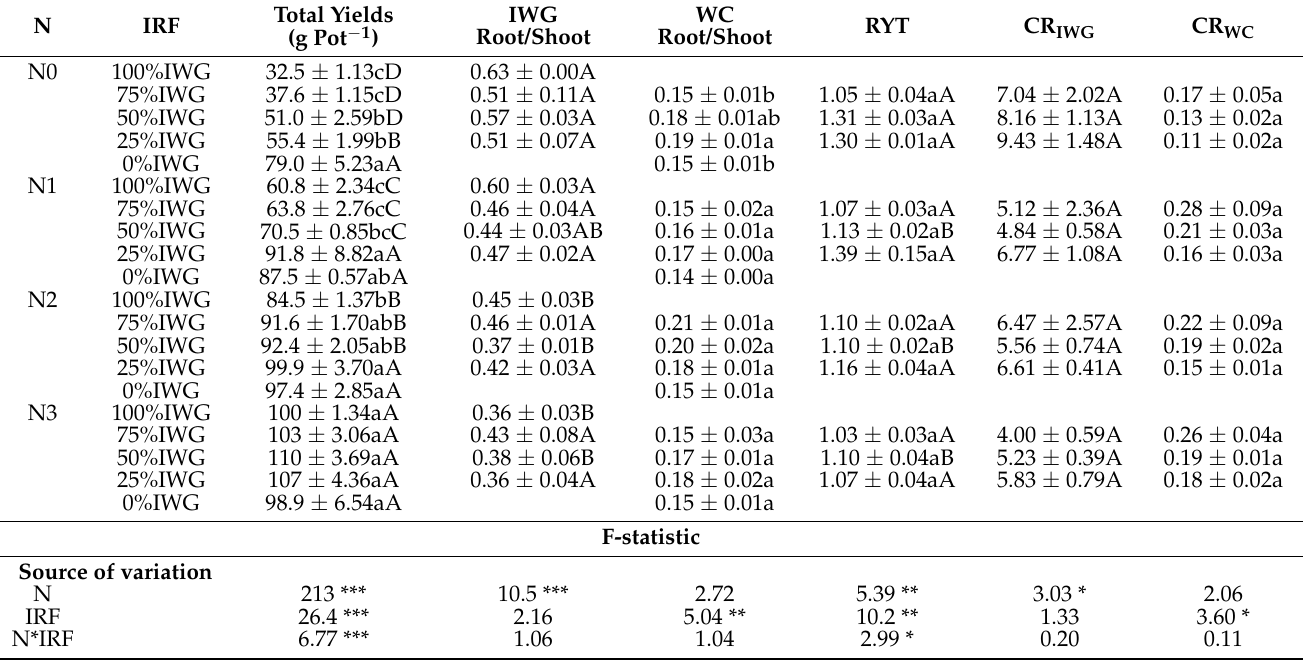
Table 2. The total dry matter yields per pot, root/shoot ratio of intermediate wheatgrass (IWG) and white clover (WC), relative yield total (RYT), and the competitive ratio of IWG (CR IWG ) and WC (CR WC ) under five relative frequencies of IWG (IRF) and four N fertilizer levels (N). Data are presented as mean ± standard error ( n = 5). F-statistics and significance from ANOVA are reported below the treatment